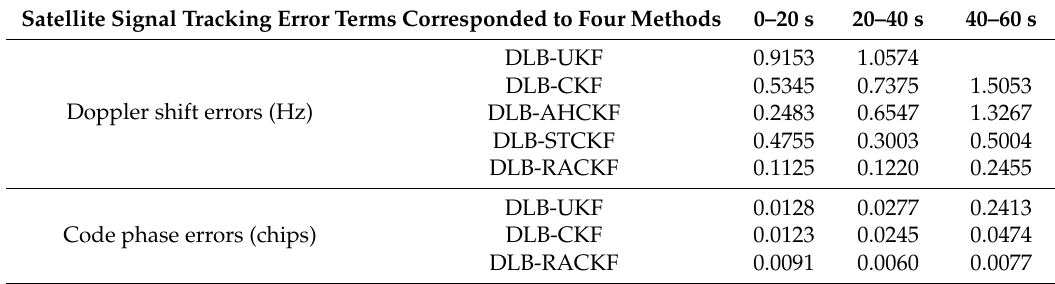
Table 1. Satellite Doppler frequency shift and code phase tracking error RMS. Table 1. S atellite Doppler frequency shift and code phase tracking error RMS.